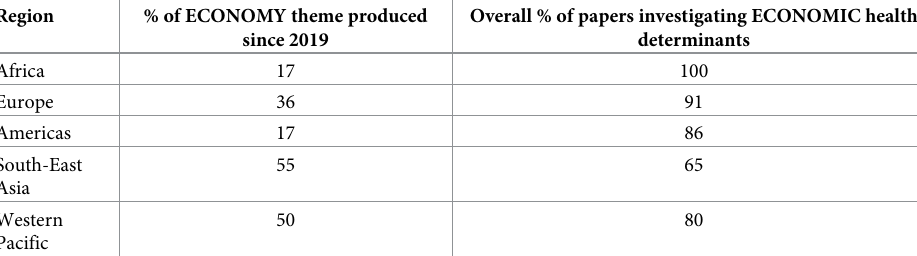
Table 3. Research outputs investigating economic drivers of health and wellbeing since 2019. Region